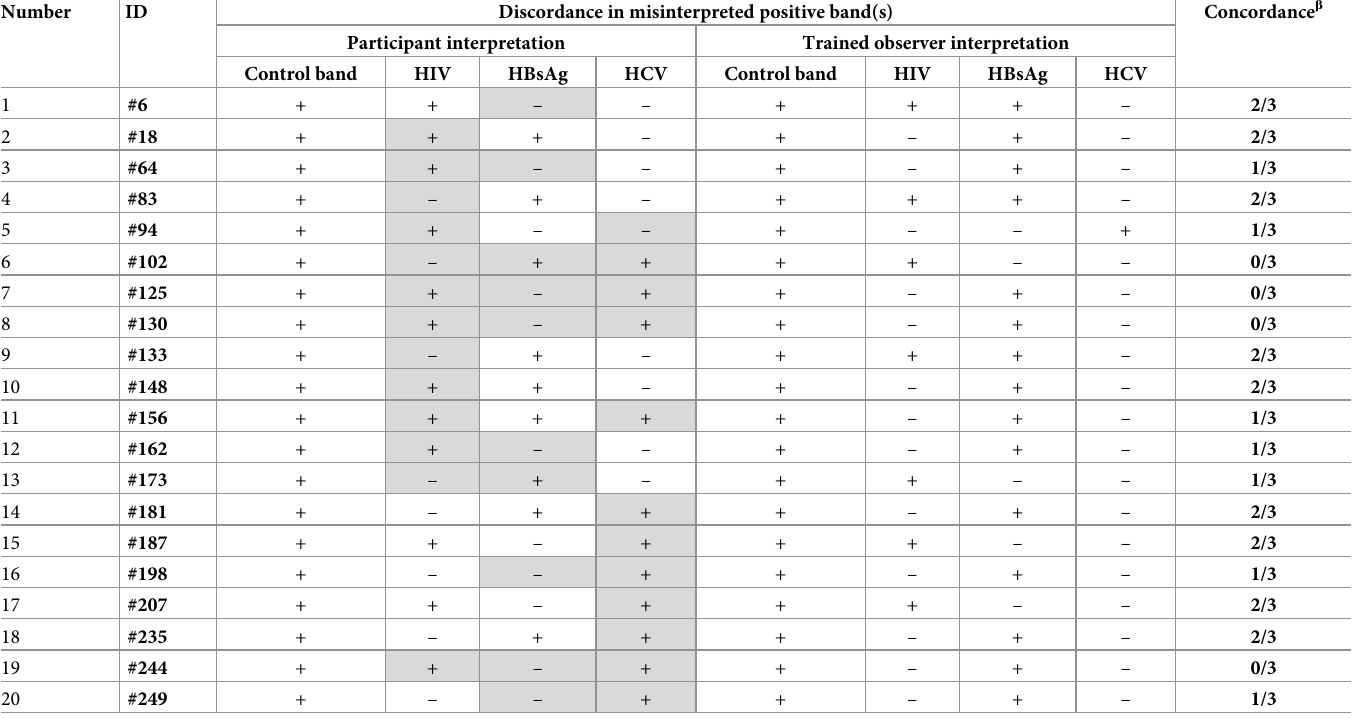
Table 5. Correspondence between the interpretation of the Triplex HIV/HCV/HBsAg self-test results by the participants and by the trained observers among 20 results of the Triplex self-test correctly identified as positive but misinterpreted because of discordance of positive